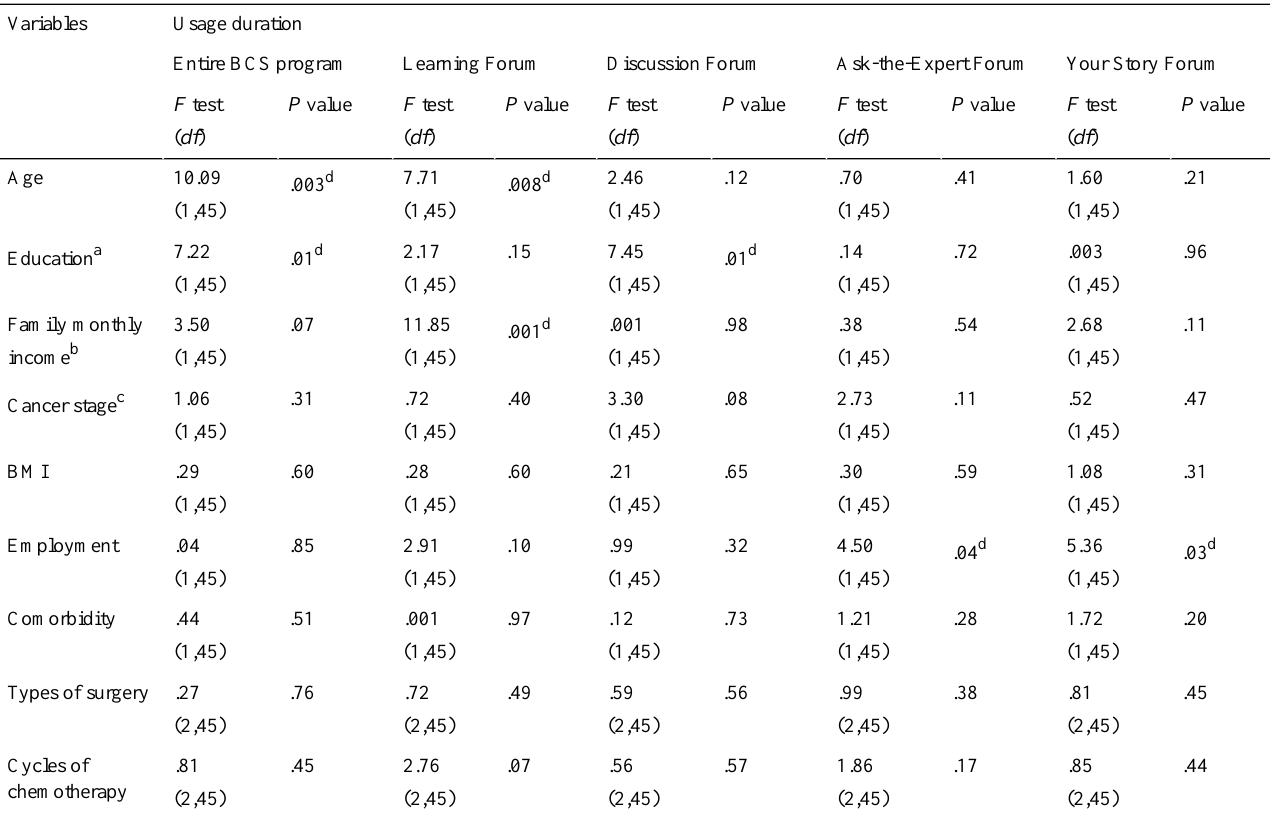
Table 2. Associations between usage duration in Breast Cancer e-Support program and demographic and clinical characteristics (n=57). Usage